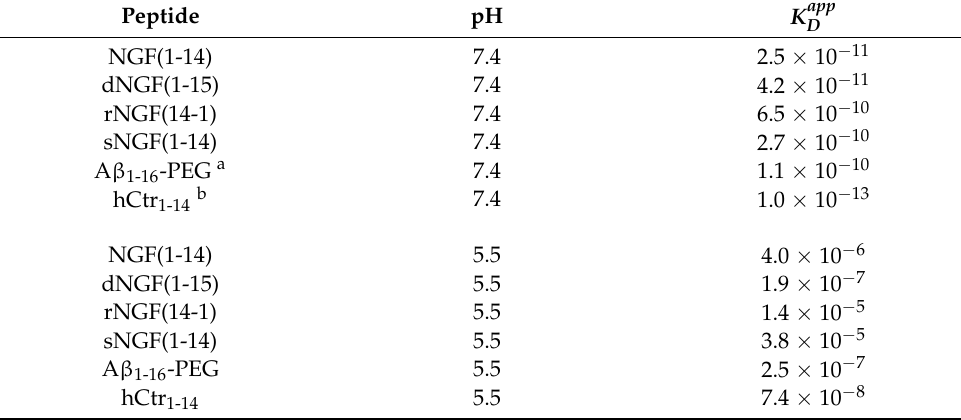
Table 4. Apparent dissociation constant values for copper(II)